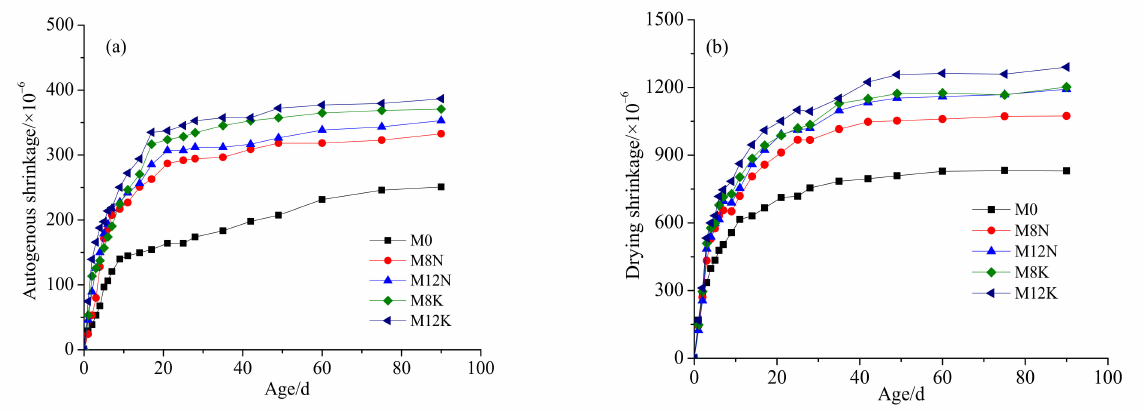
Figure 2. Shrinkage of LHPC mortars with different alkali sulfates contents. ( a ) Autogenous shrinkage; ( b ) drying shrinkage.